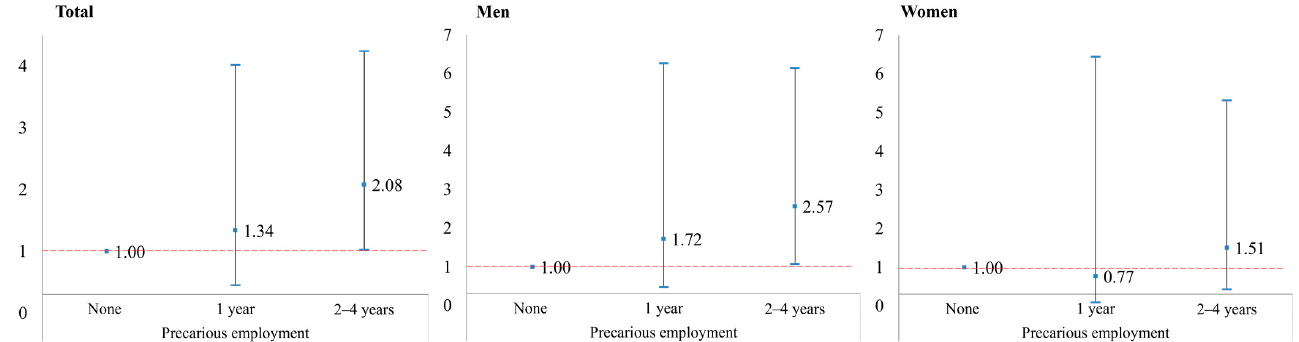
Figure 2. Fully adjusted odds ratios with 95% confidence intervals for CAGE as a screen for alcohol- use disorders according to precarious employment.